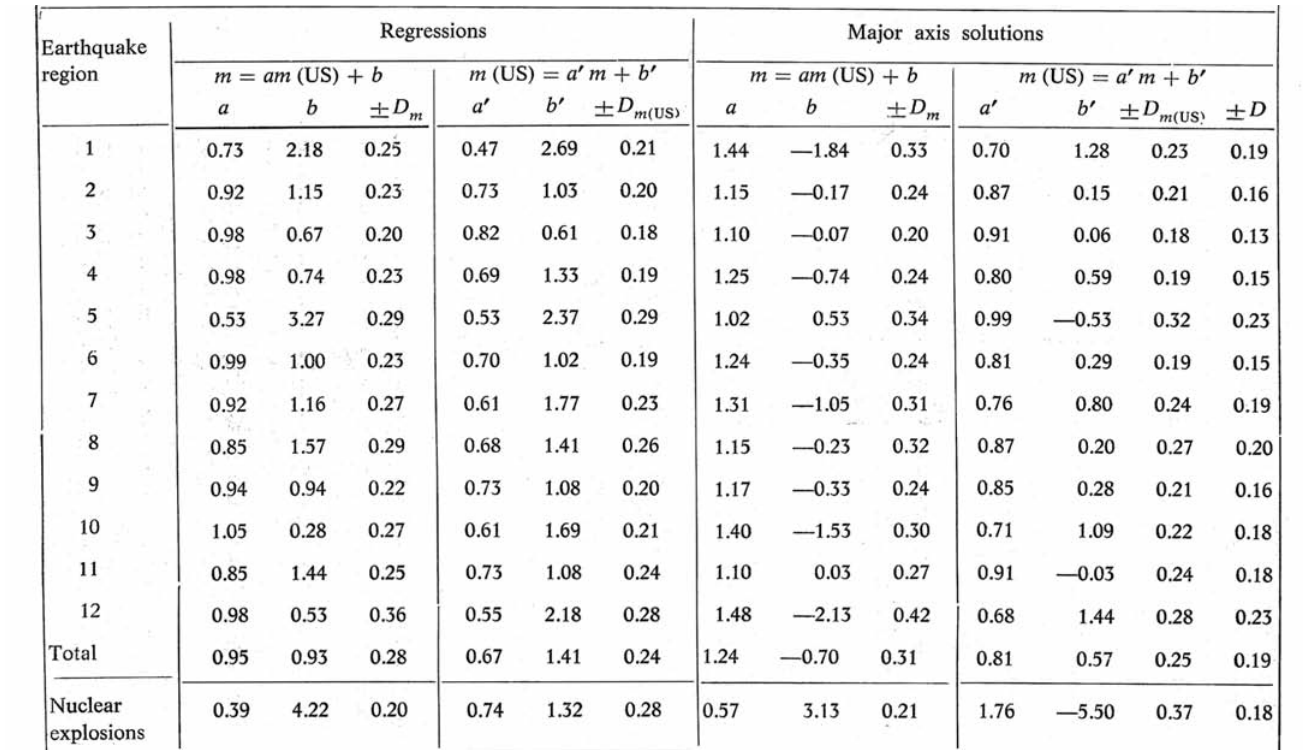
Table 6. Relations between m and m (US) for all h